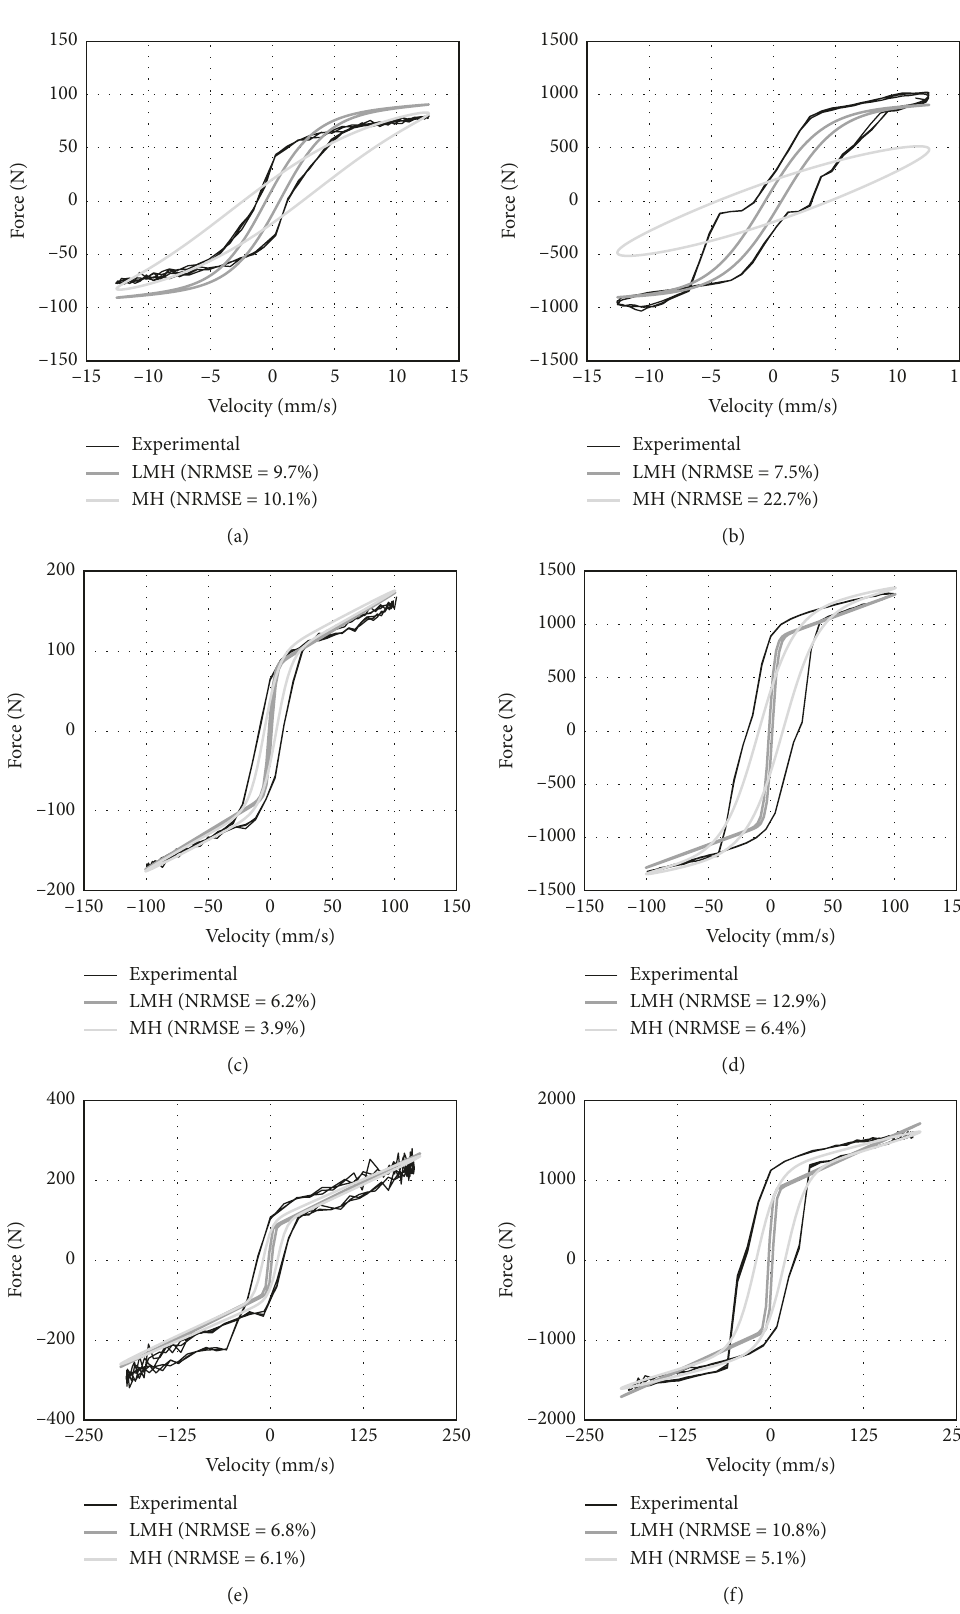
Figure 13: Shuqi-Guo model (fitted with LMH and MH tests) predictions for six different tests: (a) low velocity without intensity; (b) low velocity with I � 1 A; (c) medium velocity without intensity; (d) medium velocity with I � 1A; (e) high velocity without intensity; (f) high velocity with I �